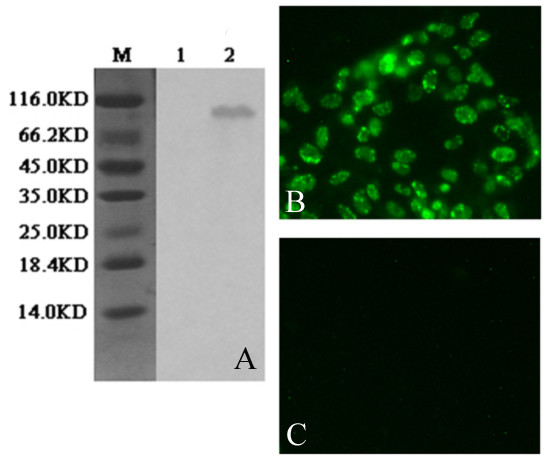
Analysis of VP2 gene expression. (A) Western blot analysis of VP2 protein expressed by infected Vero cells. Lanes: (M) Pre-stained protein markers, (1) Vector PRV SA215; (2) Recombinant PRV SA215/VP2. The 93-kDa band represents EGFP and VP2 fusion protein. (B and C) Indirect immunofluorescence analysis of VP2 protein expressed in Vero cells infected with recombinant PRV SA215/VP2 (B) and vector PRV SA215 (C). Cells infected with recombinant PRV SA215/VP2 developed immunofluorescence (B), and cells infected with vector virus PRV SA215, did not develop immunofluorescence (C).